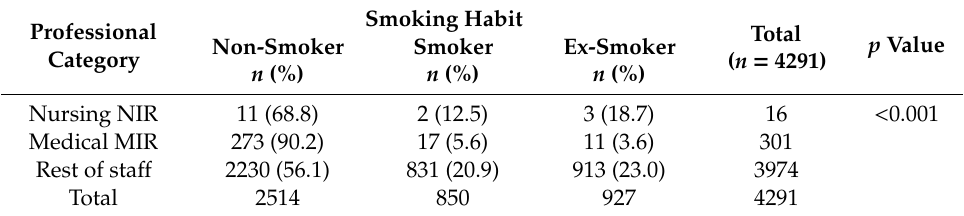
Table 3. Comparison between Medical Internal Residents (MIRs), Nursing Internal Residents (NIRs) and the other sta ff ( n =